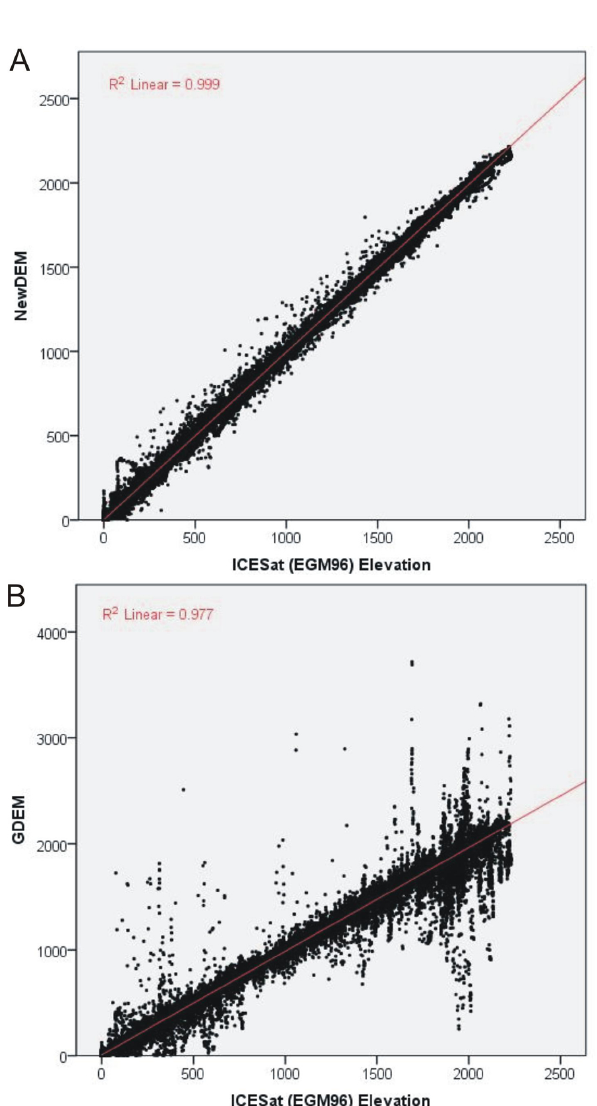
Figure 6. The relationship between ICESat footprint elevation val- ues (in metres) and the new DEM (A) and the original ASTER GDEM before correction (B)